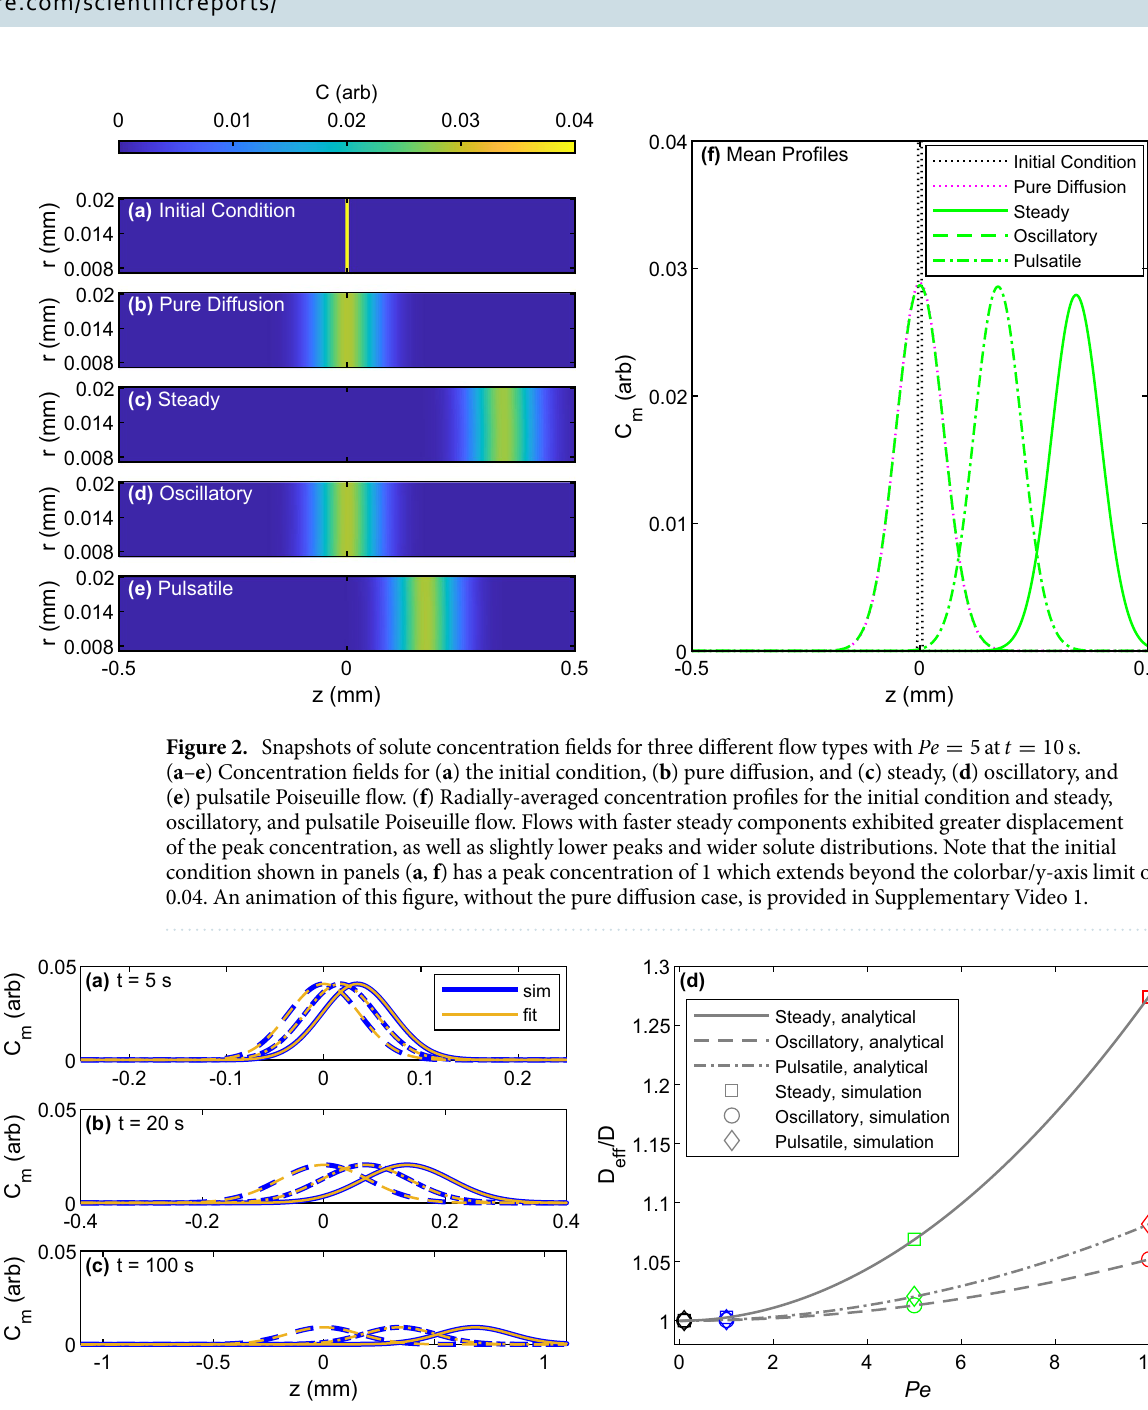
Figure 3. Snapshots of fitted concentration curves for steady, oscillatory, and pulsatile flows (continuous, dashed, and dot-dash curves, respectively) with Pe ( a – c ) have different limits in z . ( d ) Effective diffusion coefficients from analytical expressions and numerical simulations. Points are colored by Péclet number: black for Pe 10 . The discrepancy between simulations and analytical solutions does not exceed for Pe =